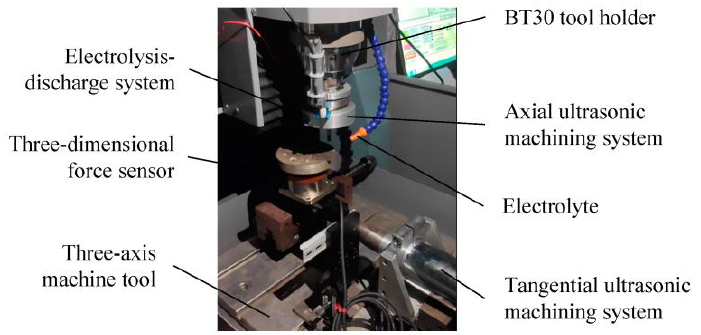
Table 1. Physical properties of the composite materials.